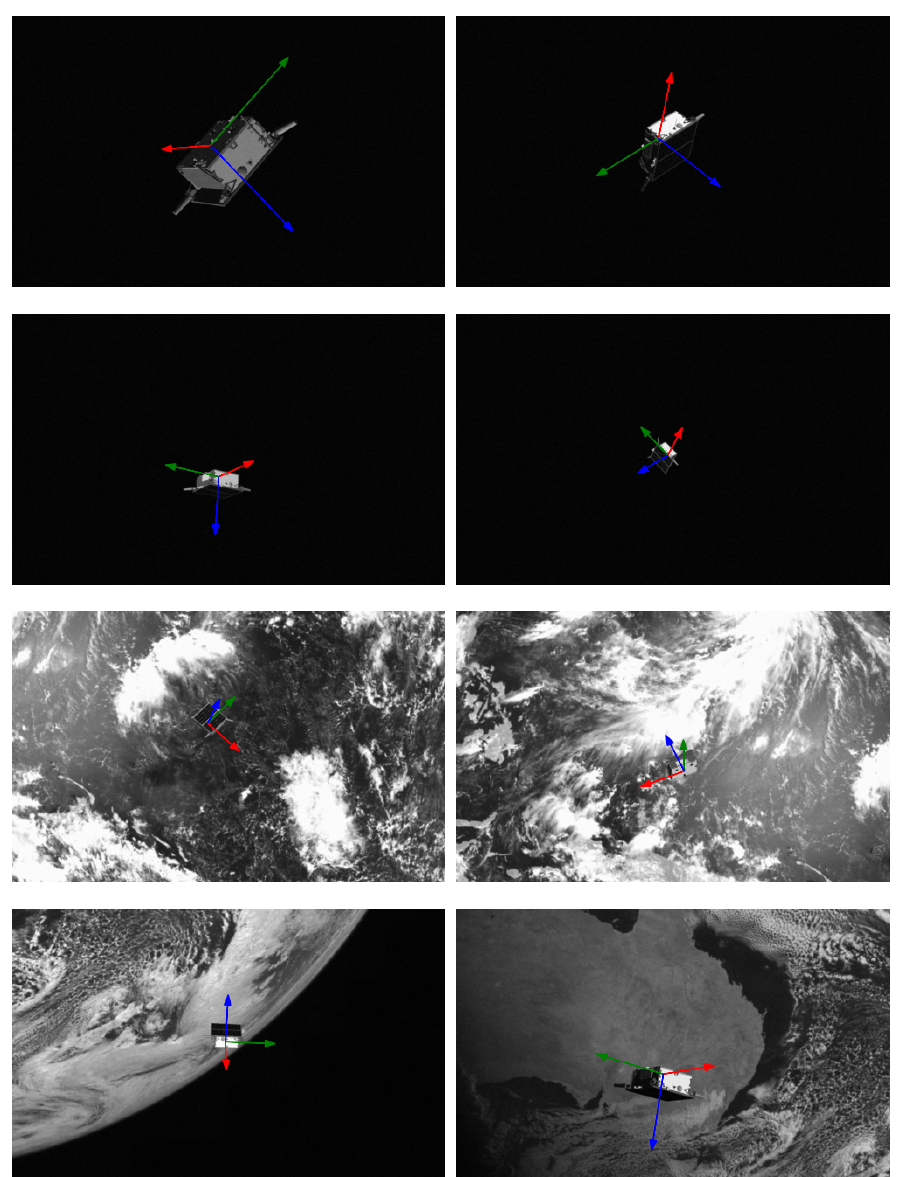
Figure 9. Qualitative results for space target pose estimation using 2D landmarks predicted by the proposed space target landmark regression network using Gaussian kernel-based 1D landmark representations at the input resolution of 512 ×